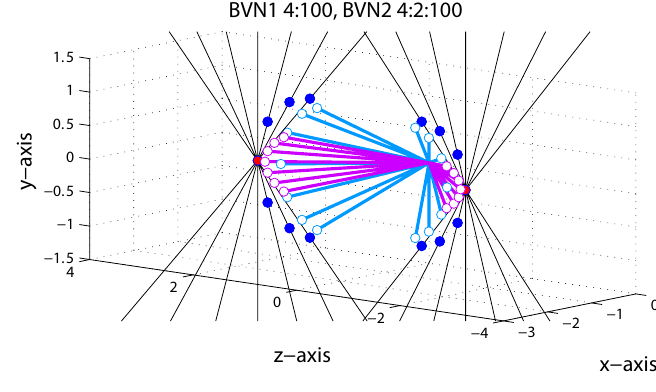
Figure 5. Model predictions for line stimuli in Exp. 1. Each of the seven black hairlines corresponds to a constraint (ICP) for a motion trajectory to the left and away from the observer ( − IOVD/far) and to the left and towards the observer (+IOVD/near). Red dots correspond to the cyclopean average (CA) and dark blue dots to vector normal (VN) predictions. Light blue and light purple open circles correspond to BVN1 and BVN2 predictions, respectively. See text for